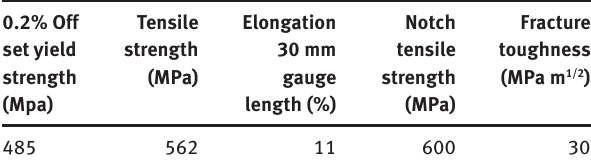
Table 2: Mechanical properties of AA7075-T651 aluminium alloy.